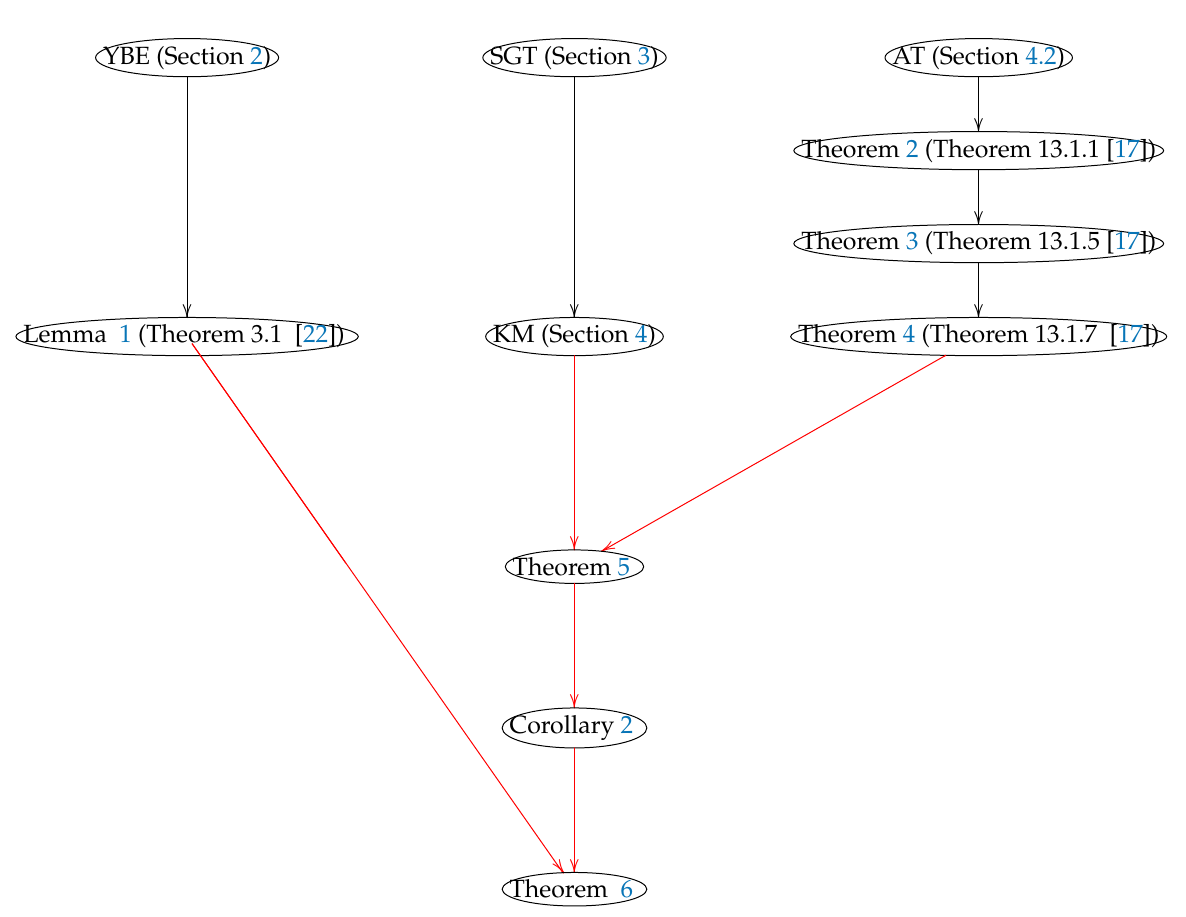
Figure 1. The main results presented in this paper (targets of red arrows) allow a connection to be established between YBE theory, the representation theory of the Kronecker algebra, the automata theory, and the snake graph theory. We use the acronyms AT, Cr, KM, Lm, Sect, SGT, Th, and YBE for automata theory, corollary, Kronecker modules, lemma, section, snake graph theory, theorem, and Yang–Baxter equation,